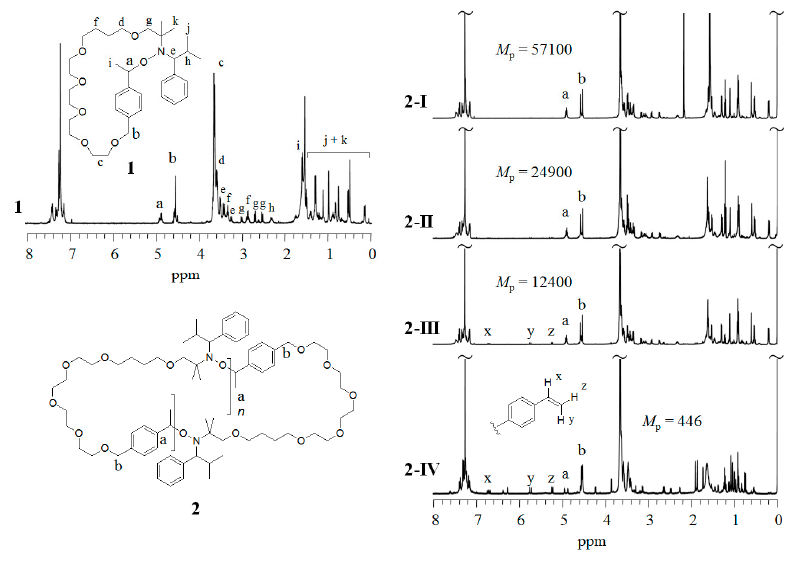
Figure 2. 1 H NMR spectra of 1 and 2-I ~ IV .